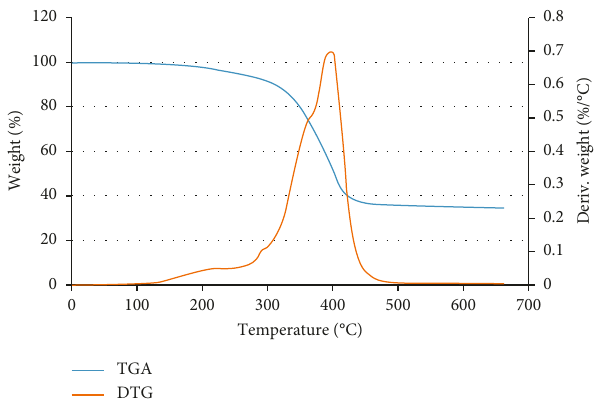
Figure 2: TGA and DTG curves of UT at 15 °